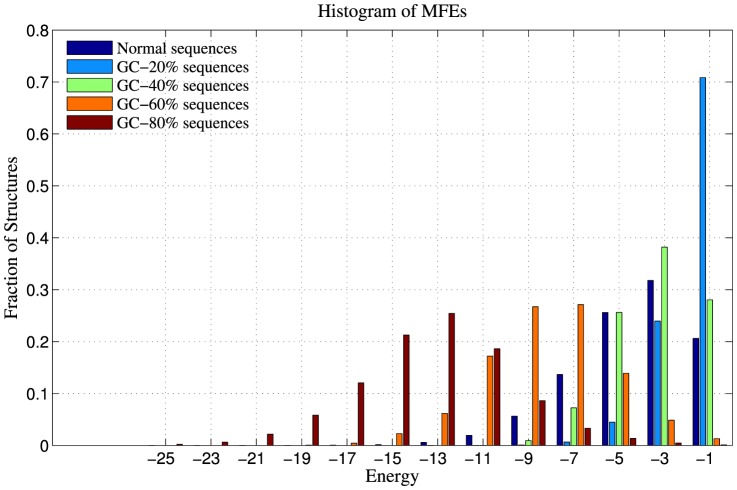
Minimum Free Energies of structures formed by RNA sequences of varied GC content.Data shown are for one million sequences of varied GC-content in comparison to normal unbiased sequences. The MFEs were calculated using viennaRNAFold routine of Vienna RNA package [10]. We observe that the Minimum Free Energies of sequences become less negative as their GC content decreases, reflecting a decrease in thermal stability.